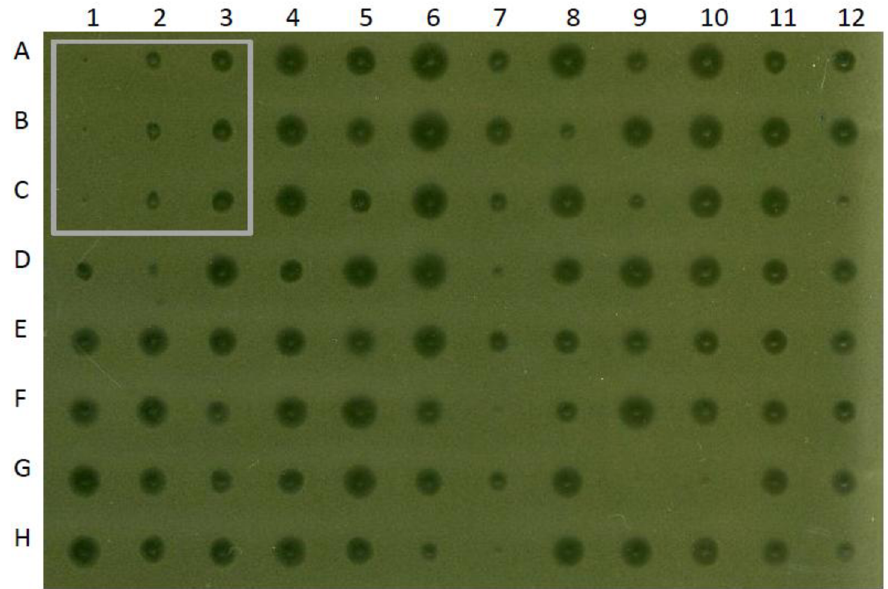
Fig 3. Illustration of the relative zones of inhibition of screened compounds versus MU1140 and OG253. Controls are boxed in the upper-left corner and include blanks (Column 1, negative control), MU1140 (Column 2, positive control) and OG253 (Column 3,